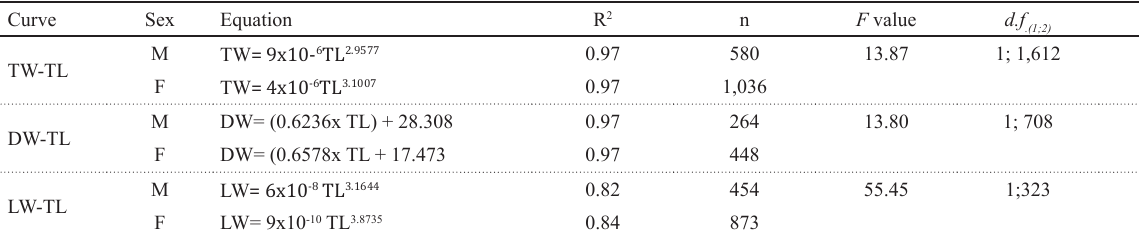
Tab. 2. Relationships analyzed for Sympterygia bonapartii from San Matías Gulf (Argentina) . Total length (TL; mm), disc width (DW; mm), total weight (TW; g); liver weight (LW; g) for males (M) and females (F); correlation coefficient (R 2 ) and sample number (n); F- test